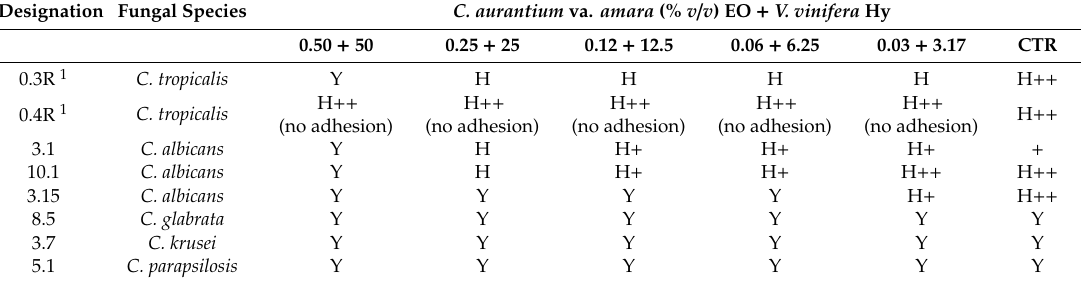
Table 4. E ff ectiveness of a mixture of C. aurantium var. amara EO and V. vinifera cv italia Hy on the morphology of clinical fungal